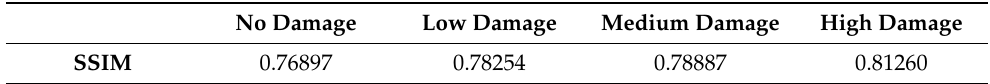
Table 18. Average mean over 150 samples.